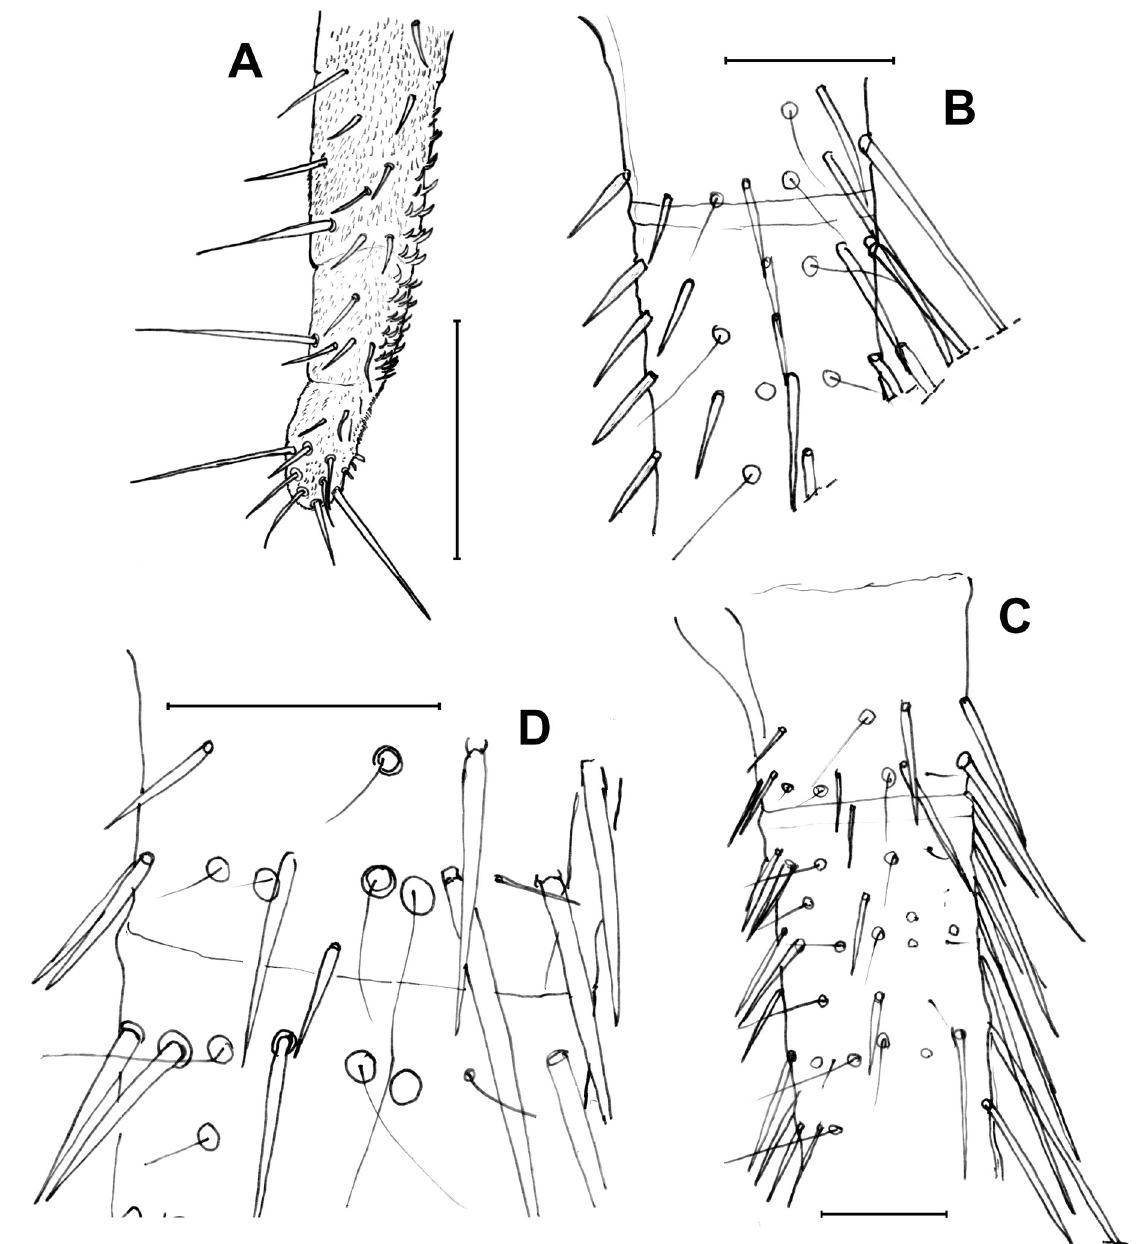
Fig. 5. Coletinia dalmatica Molero-Baltanás, Fišer, Bach de Roca & Gaju-Ricart sp. nov. A, C – D . Paratype, ♀ (MNCN_Ent 283559). B . Holotype, ♂ (MNCN_Ent 283558). A . Apex of the gonapophysis IX. B . First and second divisions of the cercus. C . First and second divisions of the cercus. D . Detail of the limit between the first and the second division of the cercus. Scale bars = 0.1